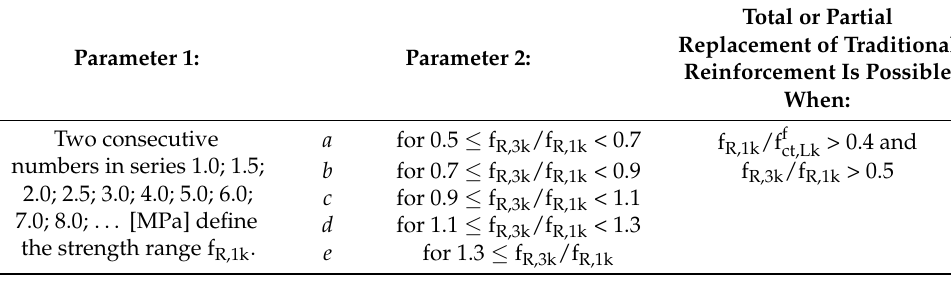
Table 11. Principles of FRC classification according to Model Code 2010 [26].